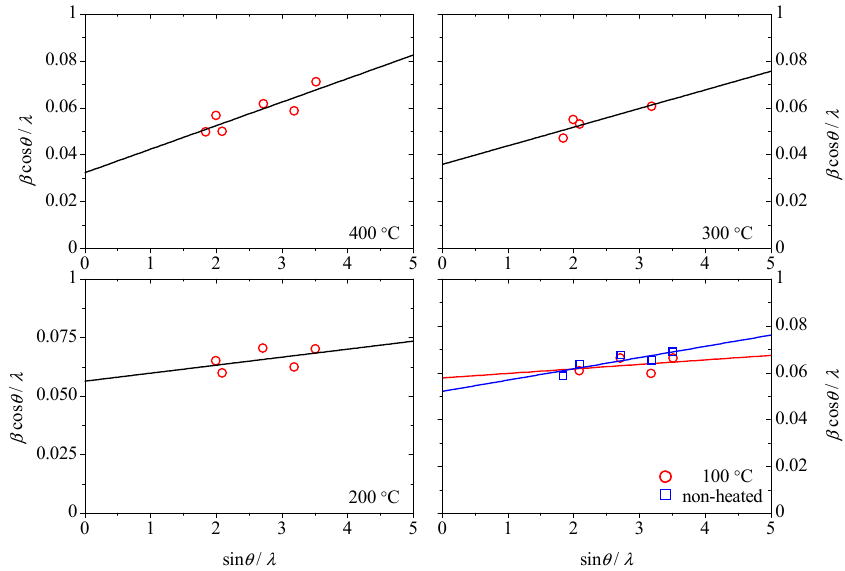
Figure 9. Williamson-Hall analysis of the X-ray diffraction patterns of the AlN:Er films deposited under different substrate temperatures conditions.